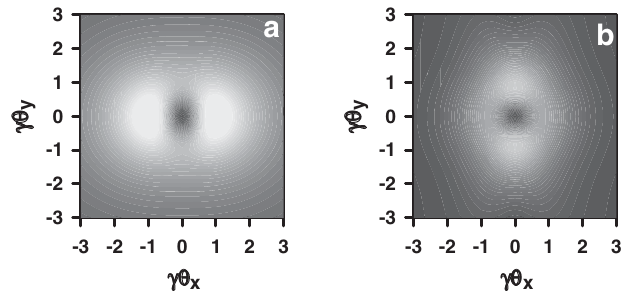
FIG. 2. (a) Angular distribution of TR from a particle crossing an infinite boundary. (b) Angular distribution of DR from a particle moving through a slit between two